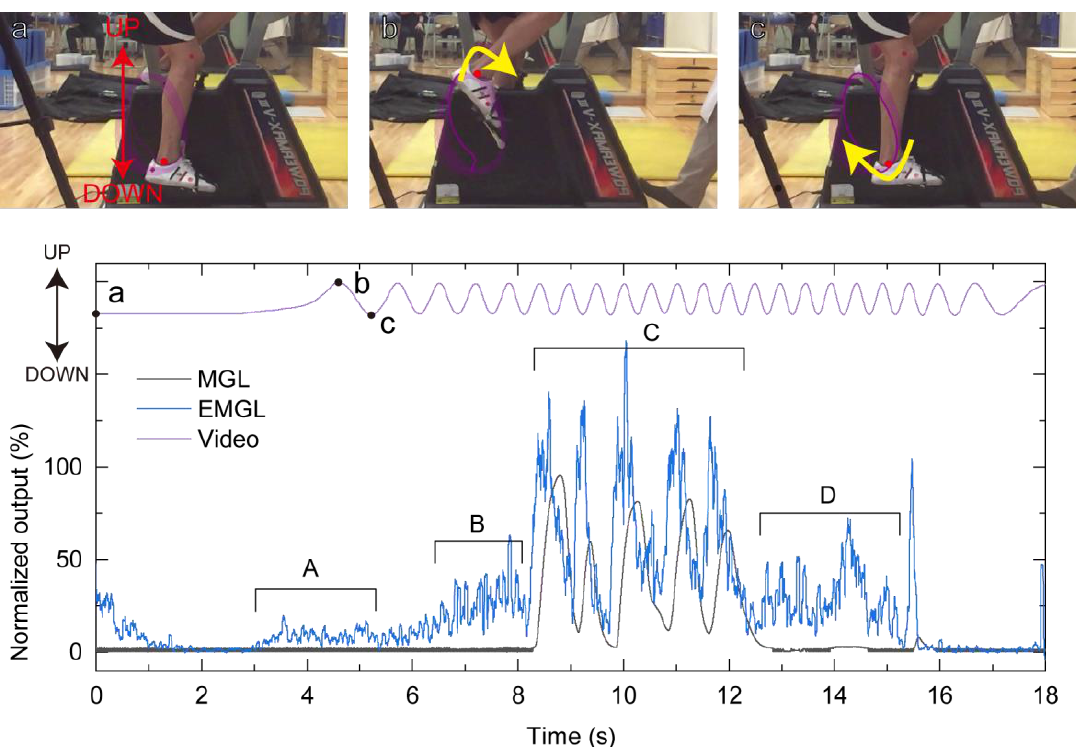
Figure 7. Outputs of left-side sensors (MGL and EMGL) compared with the video-motion analysis during the exercise tolerance test. Although EMGL shows approximately 5–40% output during periods A, B, and D, the MGL output shows almost 0%. This means that the participant did not clench the teeth even when masseter muscle activity was detected. In periods C, both MGL and EMGL indicate high levels, around 100%, meaning the participant clenched the teeth.